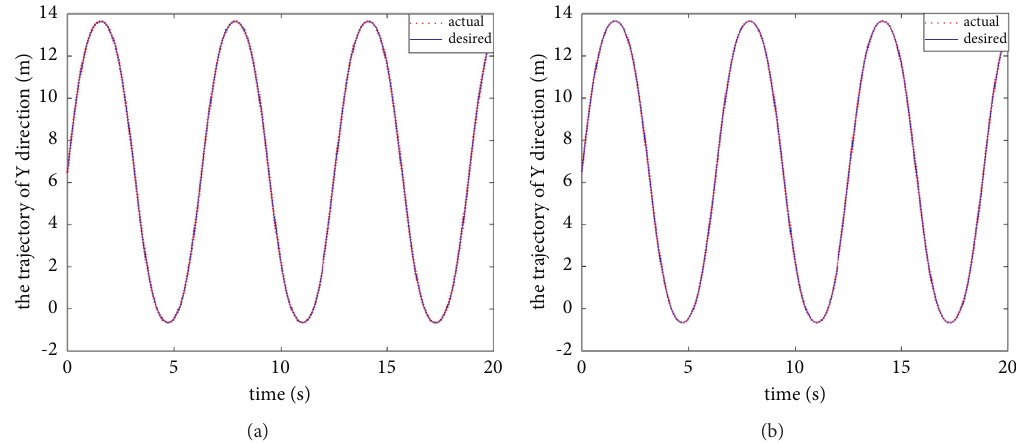
Figure 8: The trajectory tracking of work platform in the vertical y direction under the action of (a) backstepping control and (b) NN-based backstepping